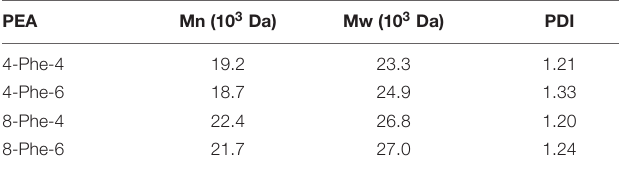
TABLE 2 | Molecular mass characteristics of Phe-PEA polymers.